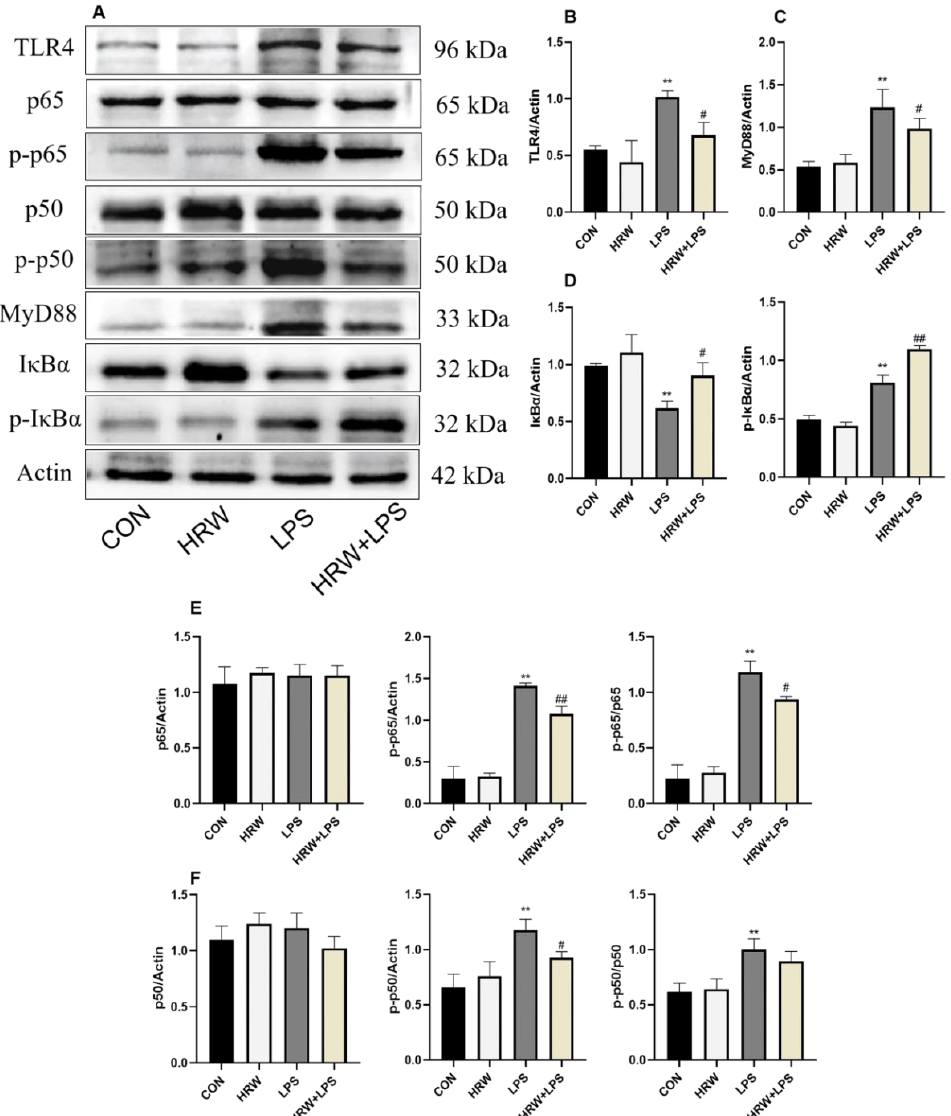
Figure 4. Effects of HRW on the NF- κ B signaling pathway in rats with chronic gut inflammation. ( A ) Blot bands of protein expression related to the NF- κ B signaling pathway. Protein expression of the NF κ B signaling pathway was detected by Western blotting: ( B ) TLR4; ( C ) MyD88; ( D ) I κ B α and p-I κ B α ; ( E ) p65 and p-p65 and their ratios; ( F ) p65 and p-p65 and their ratios. # p < 0.05; **, ## p <